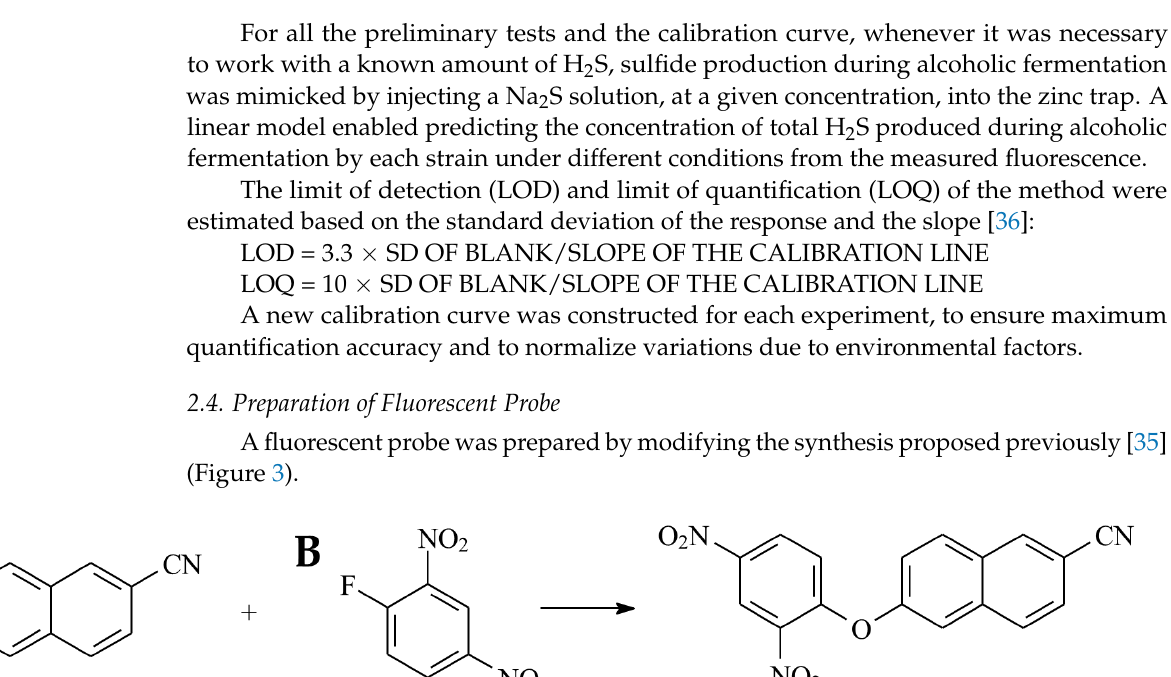
Figure 2. Visual summary of the analytical workflow.